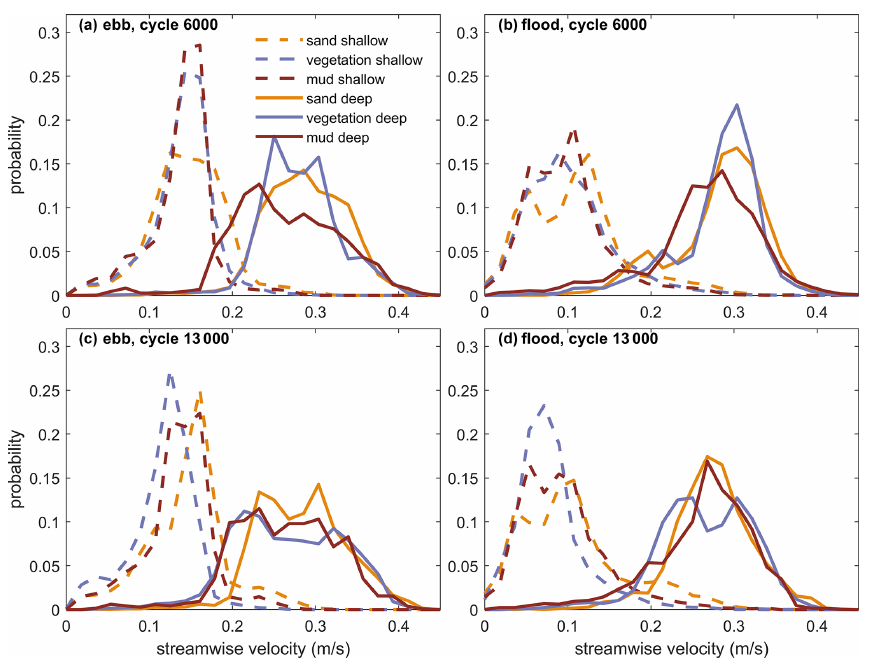
Figure 9. Distributions of maximum flow velocity calculated with the flow model for the middle (top; a,b ) and end (bottom; c,d ) of the experiment during flood (left; a,c ) and during ebb (right; b,d ). The selected depths ranges are shoal areas (0 > depth > − 0.015m) and channels ( − 0.025 > depth > − 0.050m) for consistency with Fig. 3b.